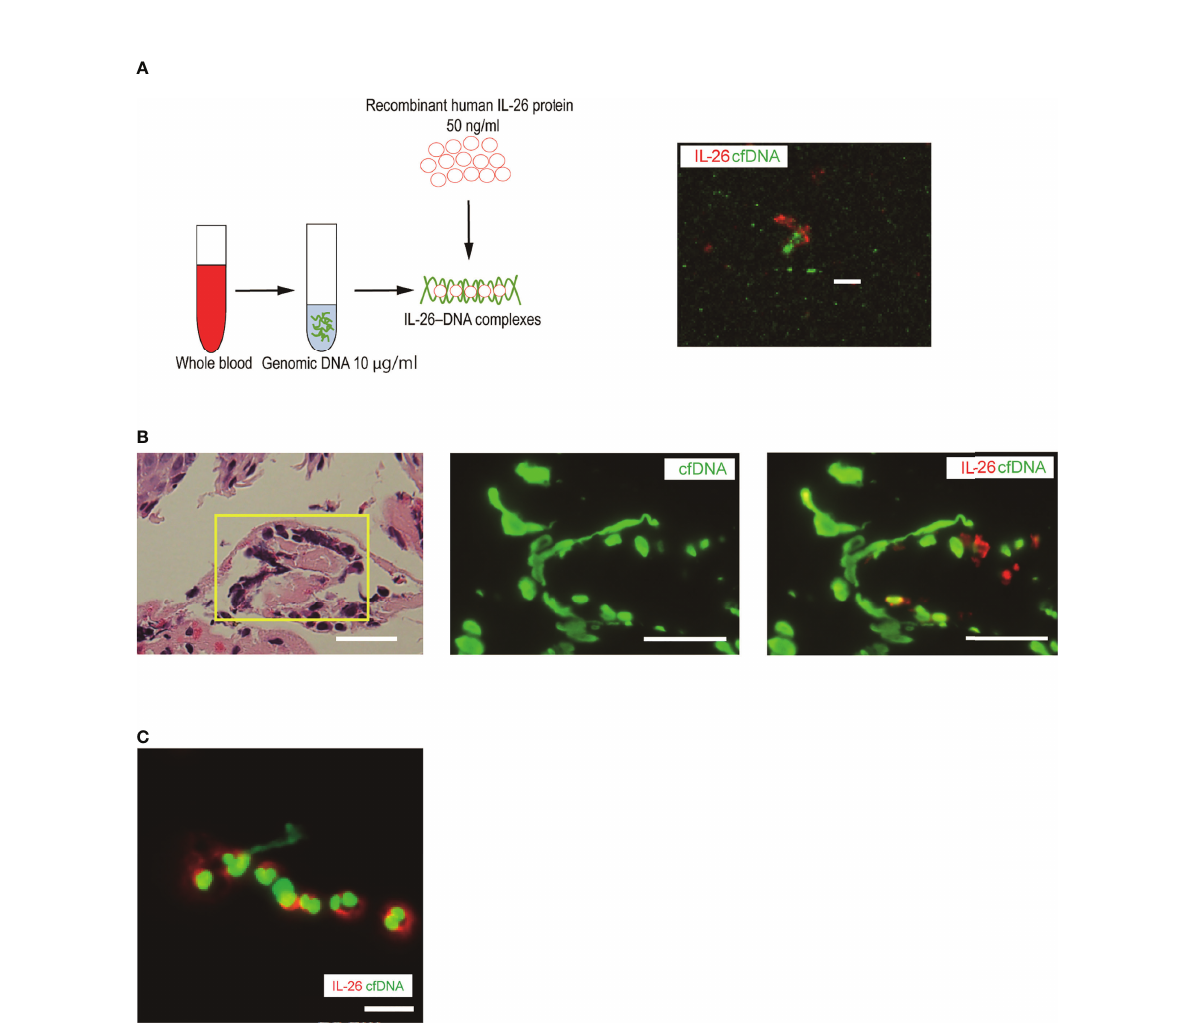
FIGURE 2 Visualization of IL-26 – DNA complexes in the skin and blister fl uid from BP patients (A) Complexes were formed by mixing human genomic DNA (green, SYTOX Green) with recombinant human IL-26 (red) for 30 minutes. The image shown is representative of three independent experiments. Scale bar, 5 m m. (B) Immuno fl uorescence images for extracellular DNA (green, SYTOX Green) and IL-26 (red) in the subepidermal blisters of skin sections from BP patients. Results are representative of three BP patients. Scale bar, 20 m m. (C) Immuno fl uorescence images for extracellular DNA (green, SYTOX Green) and IL-26 (red) in a blister fl uid smear from BP patients. Results are representative of three BP patients. Scale bar, 20 m